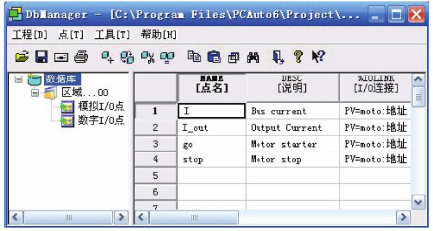
Figure 4: Variable manager